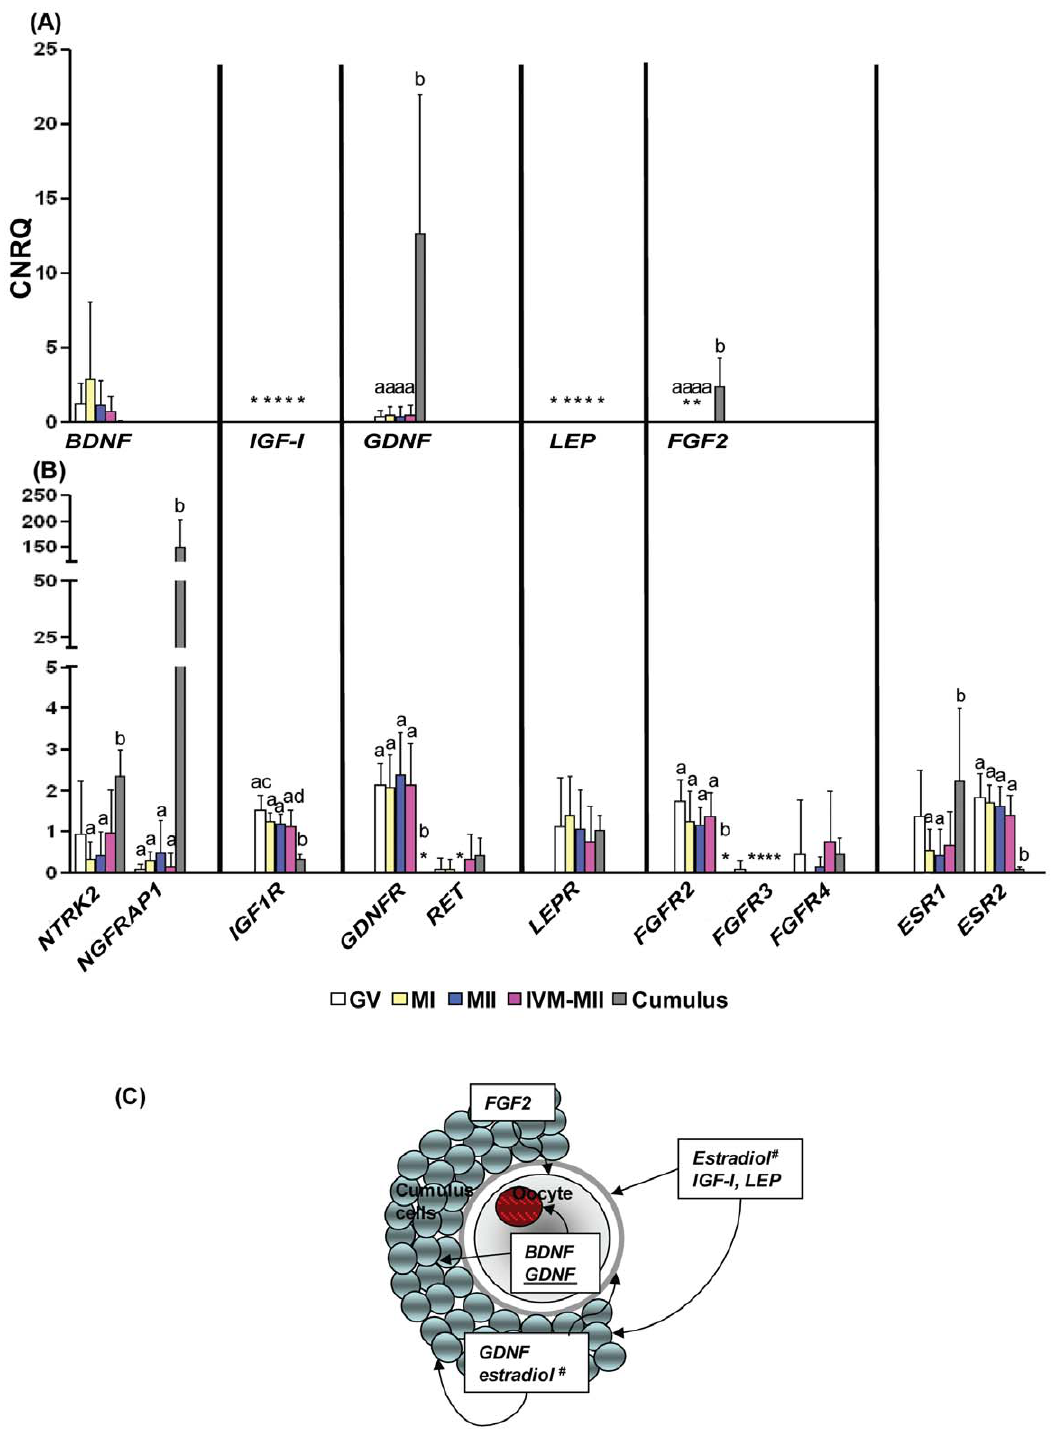
Figure 2. Expressions of ovarian paracrine/autocrine factors and their cognate receptors selected for supplementation in invitro maturation media. (A) Ovarian paracrine/autocrine ligands, (B) their cognate receptors, and (C) schematic representation of gene expressions. Values are the means of different stages of oocytes including GV (N=10), MI (N=8), MII (N=9), IVM-MII (N=10) and cumulus cells (N=5). Error bars represent standard deviation (SD). CNRQ=calculated normalized relative quantity. *: No detected in all samples. a,b or c,d : Values were significantly different (P , 0.05), underline: low expression level, # : adopted from Hillier et al. [46].